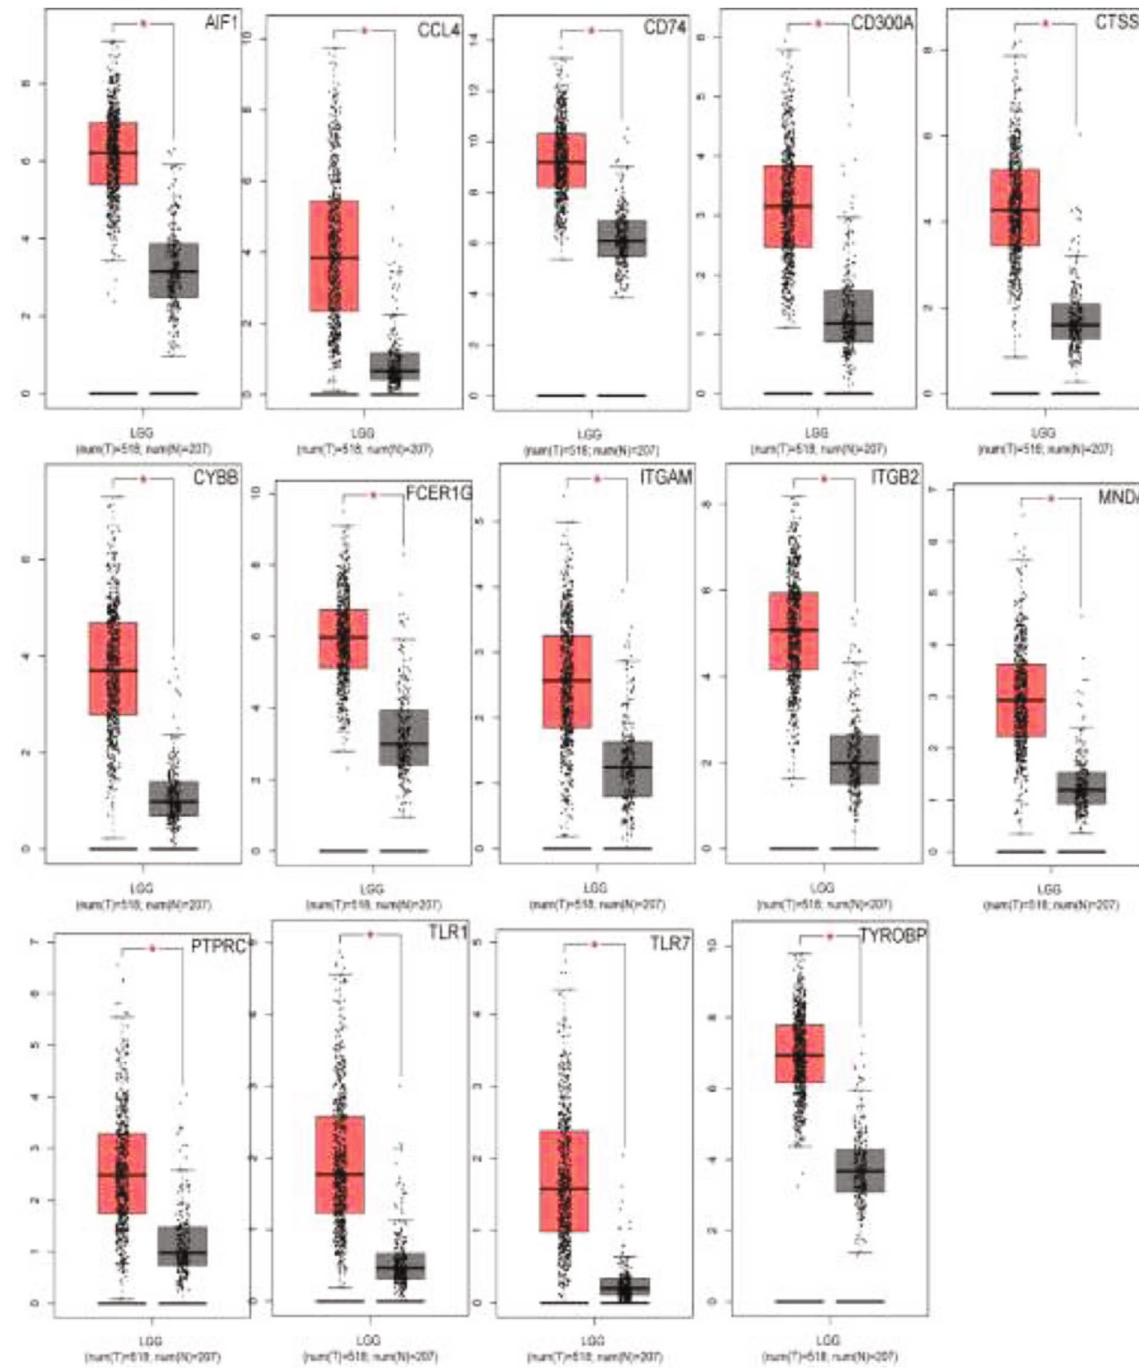
Figure 5: 18 DEGs associated with poor prognosis were analyzed through the GEPIA website. Compared with normal people, LGG patients had signi fi cant expression of 14 DEGs. ∗ P < 0 : 05 . LGG tissue is depicted in red squares and normal brain tissue in gray